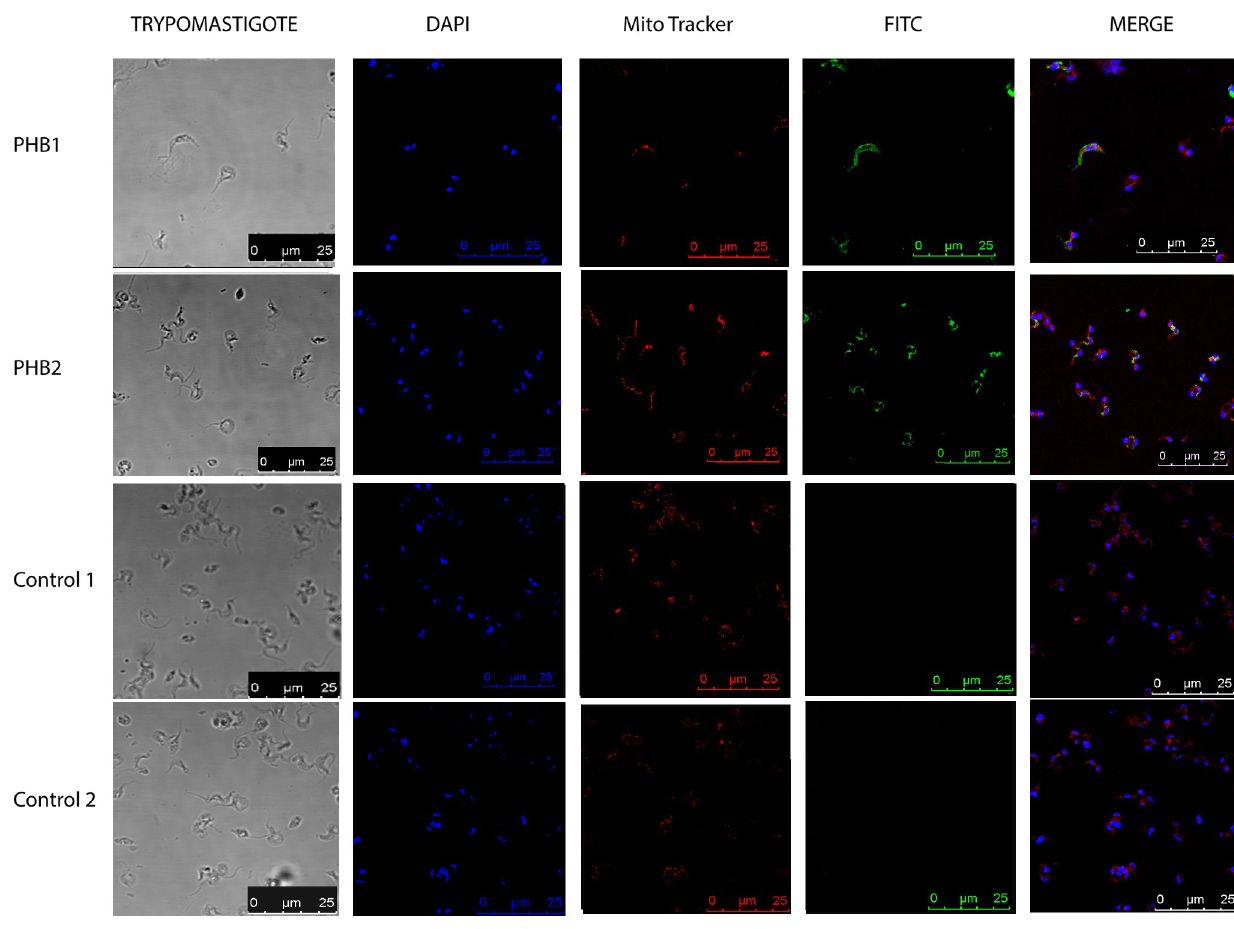
Fig 3. Fluorescence microscopy analysis in trypomastigote forms of PHB1 and PHB2 using antibodies produced against T . cruzi PHB recombinant proteins. In blue, DAPI-labeled DNA; in red, the mitochondria labeled with MitoTracker; in green, PHB1 and PHB2 detected with FITC-conjugated secondary antibody. The merged images show the overlap of the green, red and blue channels.